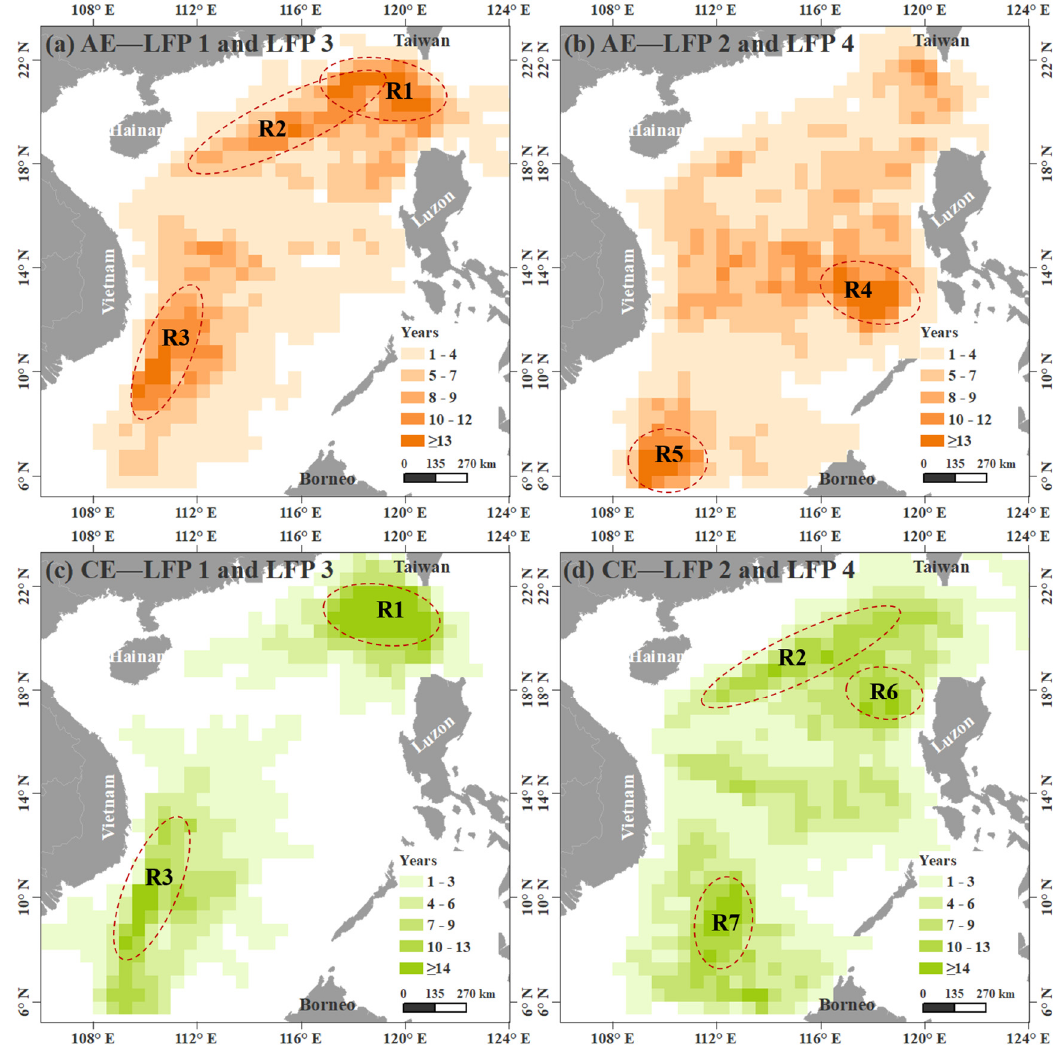
Figure 8. The migration channels as revealed by the AE and CE complex trajectory LFPs. The seven migration channels close to the AE and CE LFPs are located in the southwest of Taiwan Island (R1), the northern shelf slope of SCS (R2), the southeast of Vietnam (R3), the southwest and northwest of Luzon Island (R4, R6), and the southernmost part of the SCS (R5, R7). Along these migration channels, the LFPs show an annual periodic pattern (Table 2).